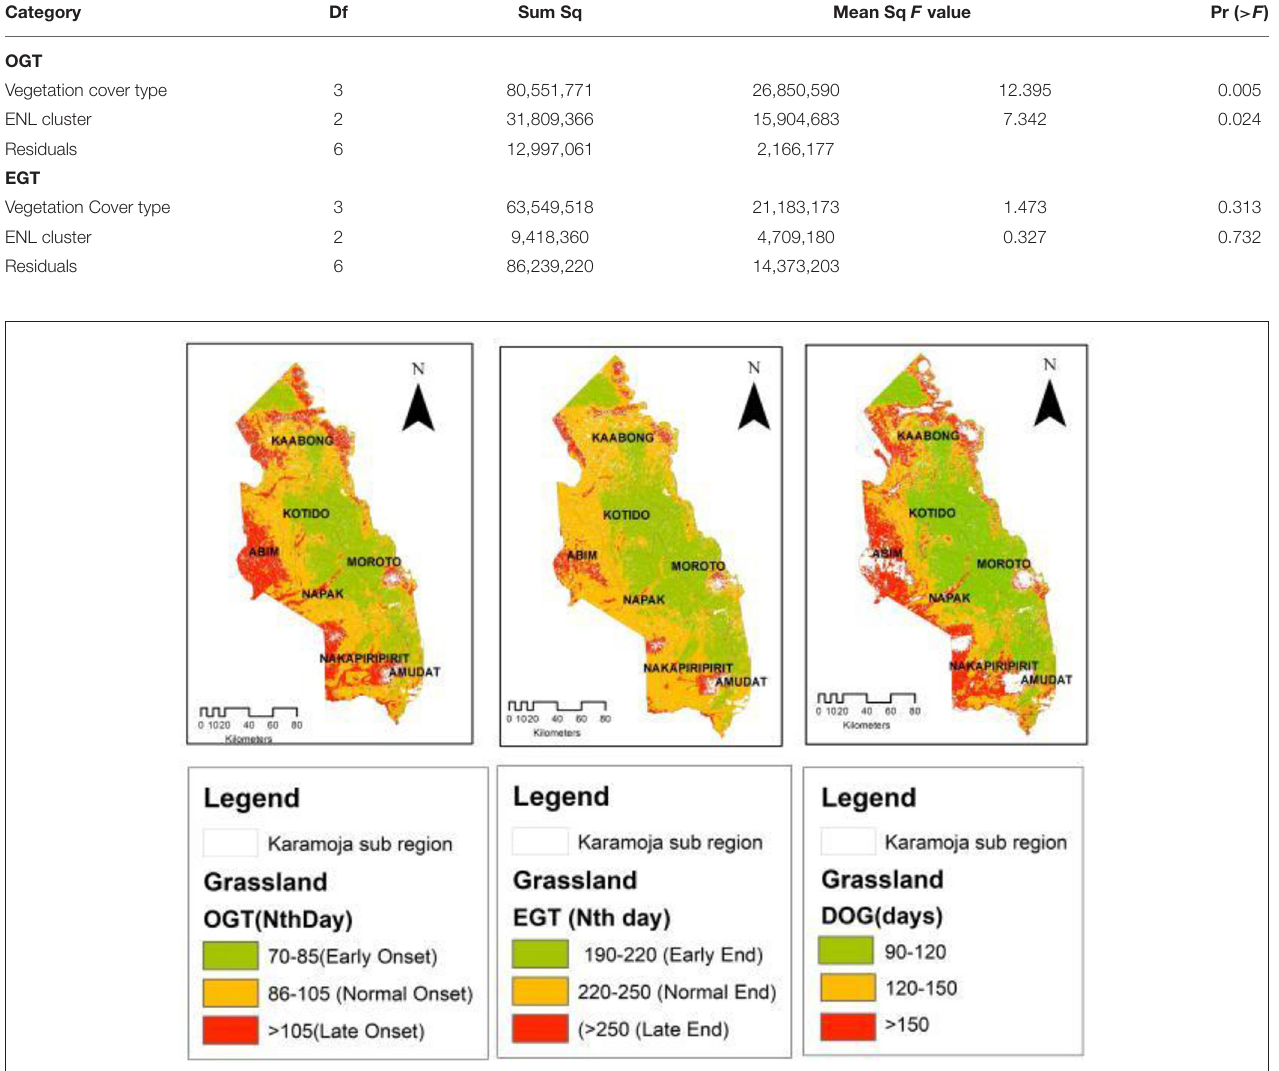
FIGURE 4 | Grassland OGT, EGT, and DOG spatial